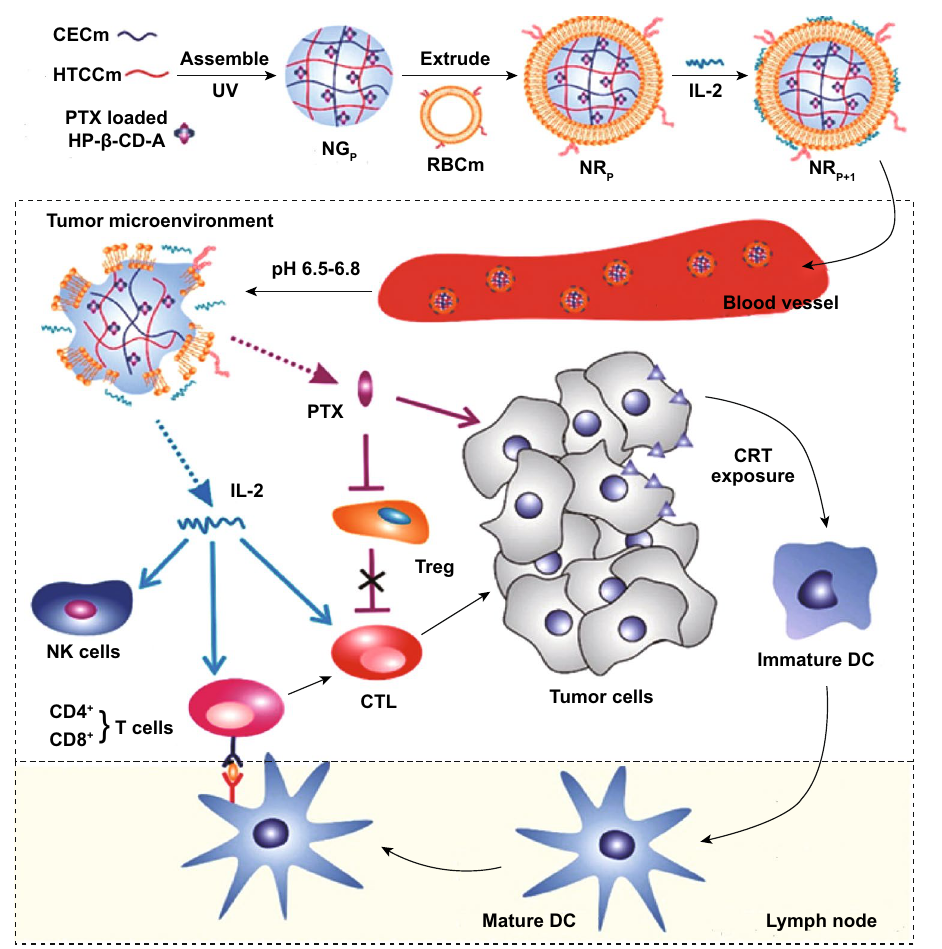
Fig. 9 Schematic illustration NR P+I for chemoimmunotherapy. Reproduced with permission from Ref. [118]. Copyright 2017 American Chemi- cal